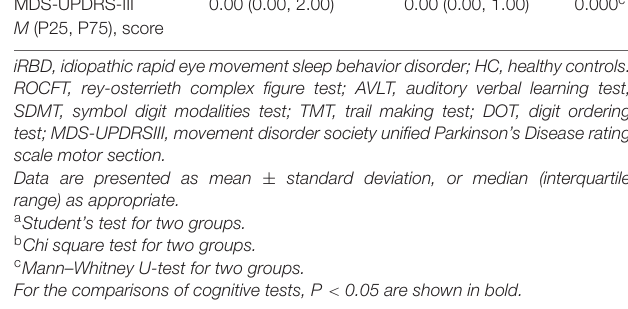
b Chi square test for two groups. c Mann–Whitney U-test for two